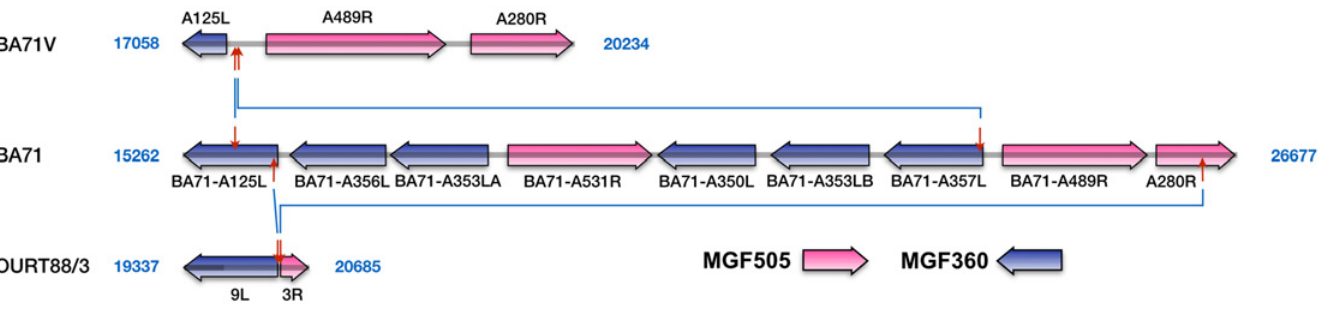
Fig 4. Comparison of the genomic structure of BA71 with BA71V and OURT88/3 around difference 15. The figure shows a representation to scale of the genomes of BA71, BA71V and OURT88/3 around the position of BA71-BA71V difference 15 (the exact positions are indicated for each of the genomes). Red arrows delimit non-identical regions. Blue lines connect arrows at equivalent positions. The different groups of ORFs are identified by colors as indicated in the figure.